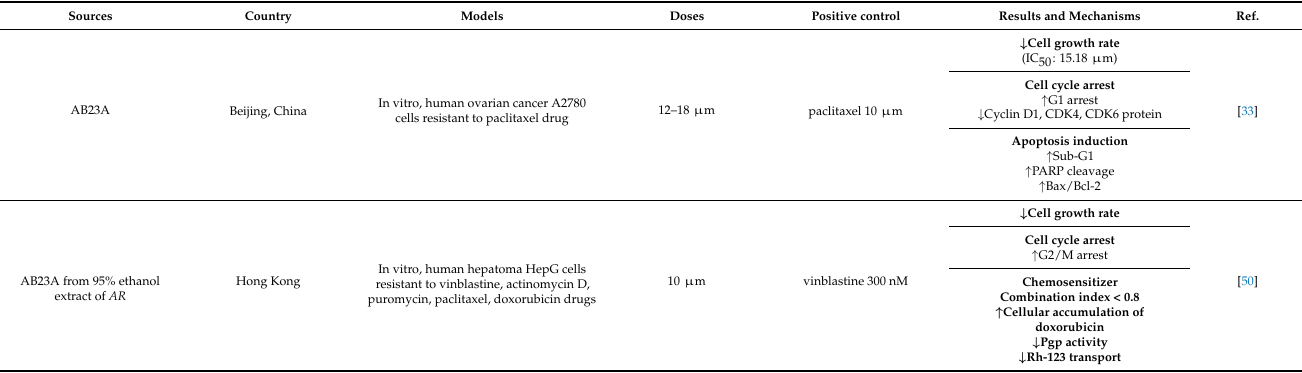
Table 3. Antiresistant effects and molecular mechanisms of AR and its